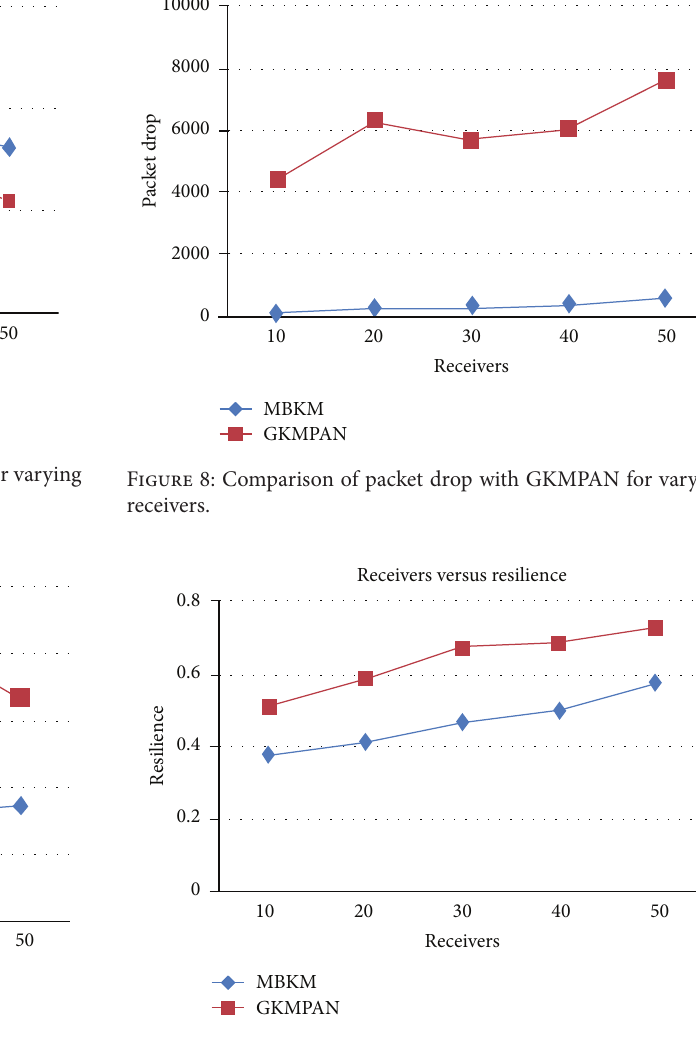
Figure 9: Comparison of resilience with GKMPAN for varying